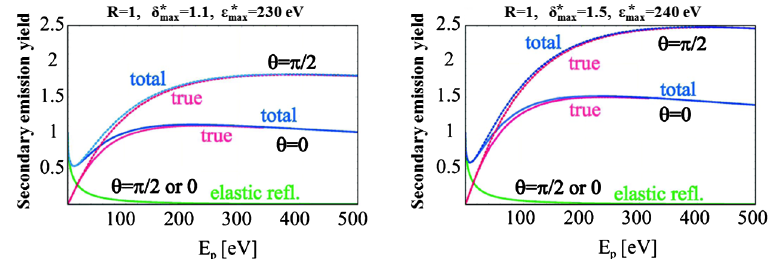
FIG. 3. The secondary-emission yield (cid:1) tot plus its true and elastic components as a function of the incident primary electron energy E p , for perpendicular incidence and incidence at an angle of primary electron energy at which the secondary yield assumes its maximum value), and with an elastic reflectivity R ¼ 1 , according to the model described in the